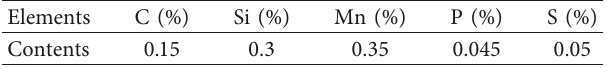
Table 1: The chemical compositions of steel Q235.